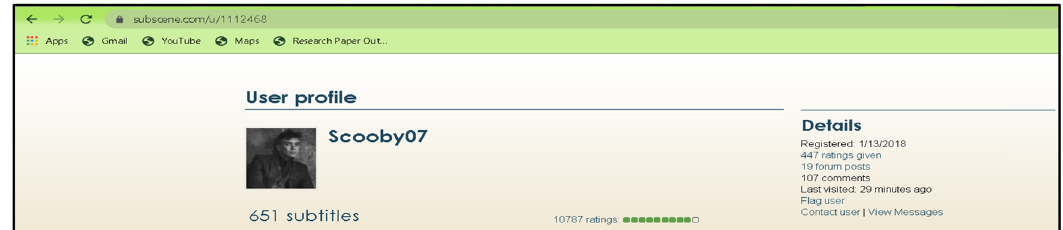
Figure 1: Screenshot from the website showing the pro fi le of the fansubber.